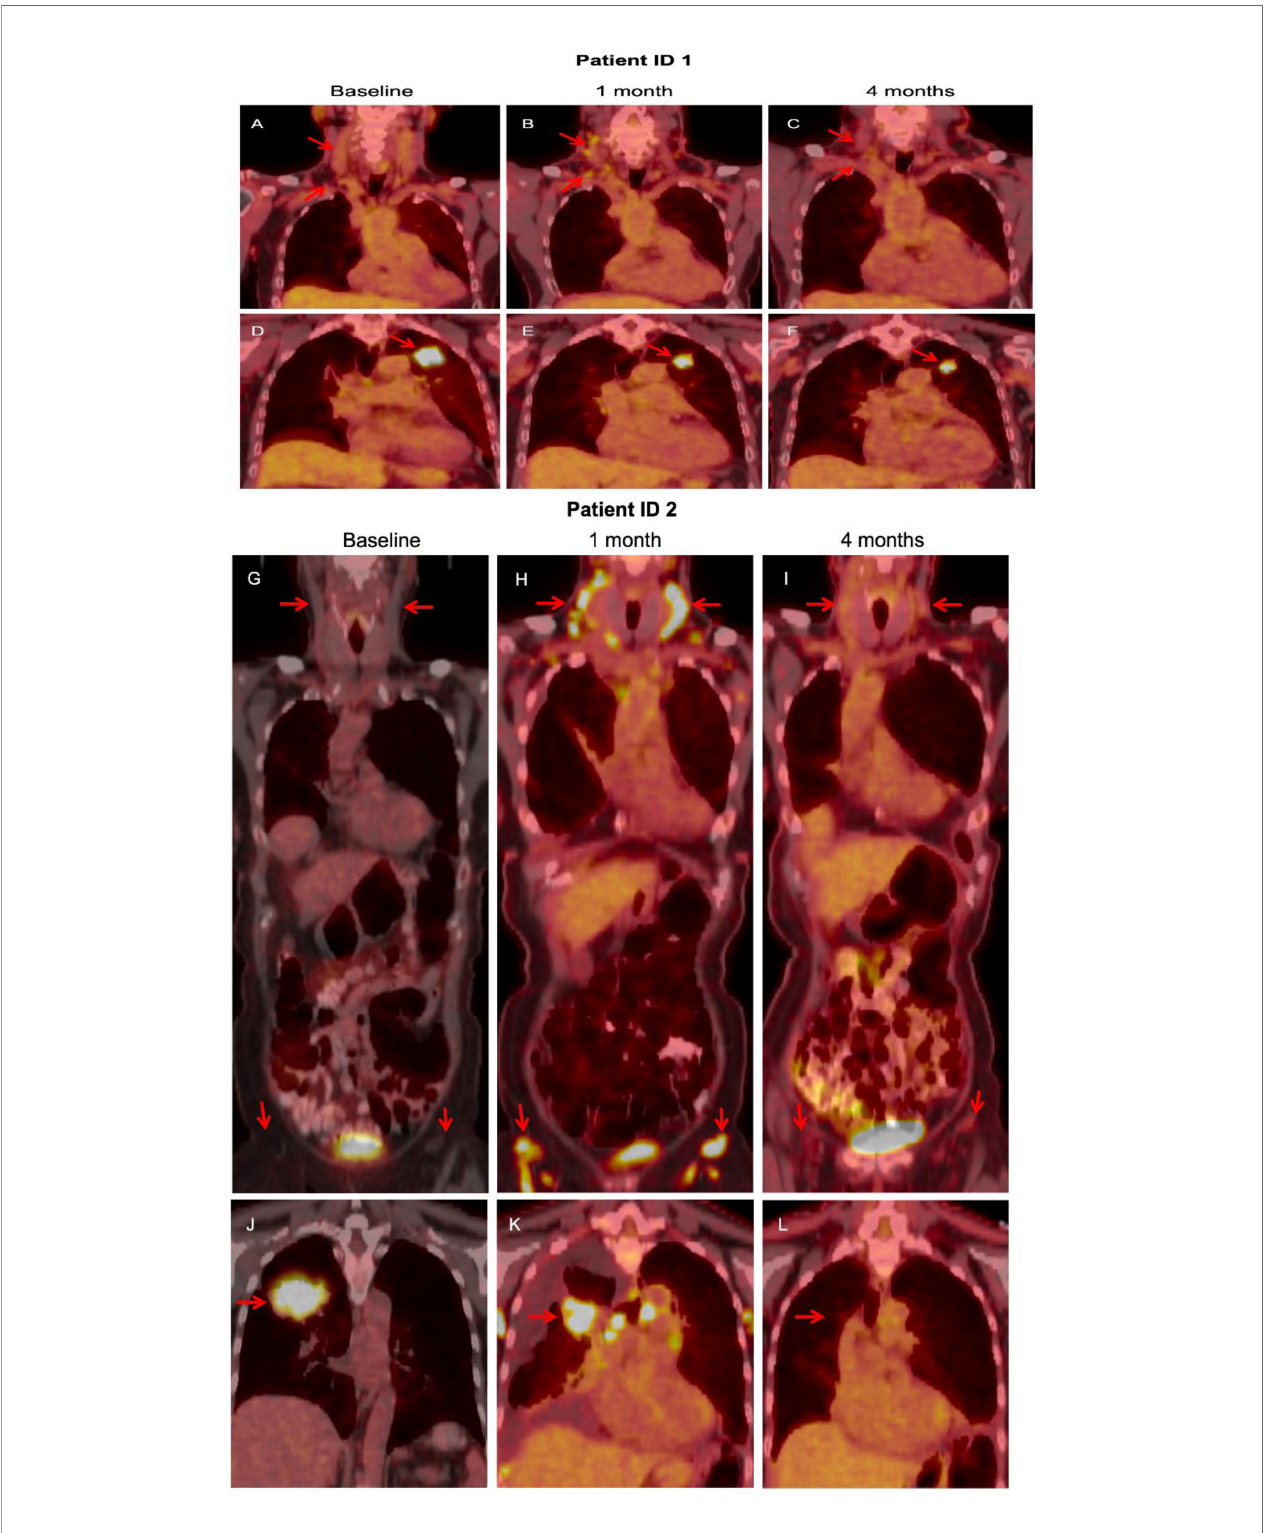
FIGURE 4 | In patient ID 1, FDG-PET obtained after 1 cycle showed diffuse update in cervical lymph nodes (B) , compared with baseline (A) , which resolved at 4 months (C) . The primary lung lesion continued to shrink with study treatment (D – F) . In patient ID 2, a similar pattern was noted. FDG-PET obtained after 1 cycle showed diffuse update in cervical and inguinal lymph nodes (G) , compared with baseline (H) , which resolved at 4 months (I) . The primary lung mass responded to study treatment (J – L) .